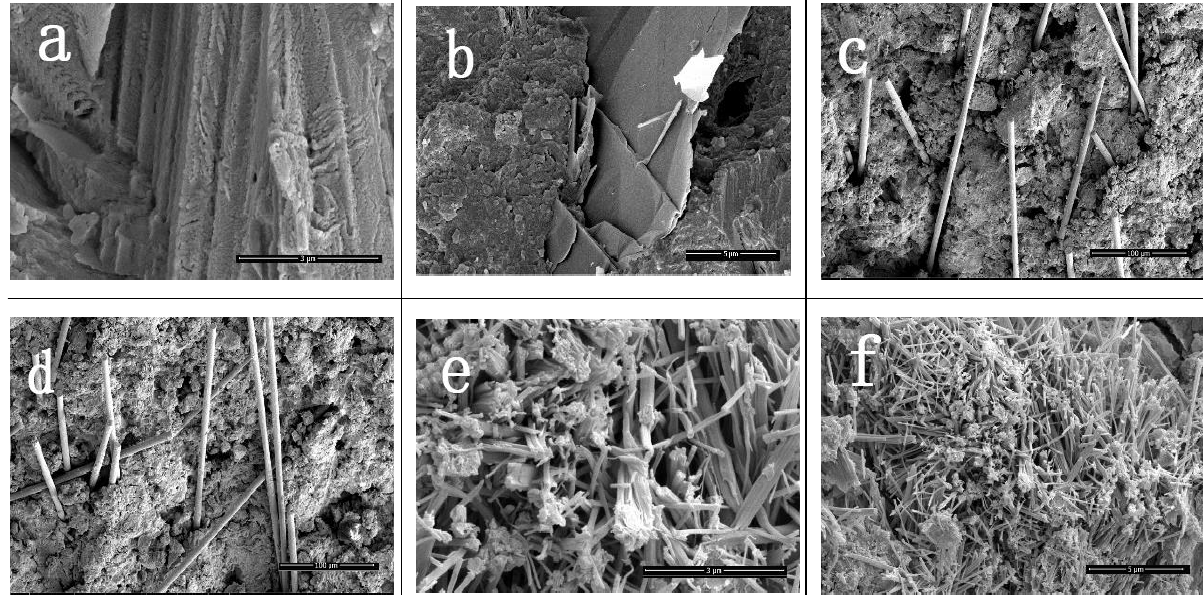
Figure 4: The SEM images of the absorbing layer and the absorbing & reflecting layer of GPE1~GPE3 (a) 0.025%NGPs+0.75%Ni; (b) 0.05%NGPs+0.75%Ni; (c)(e)0.5%CF+4%CB; (d)(f)